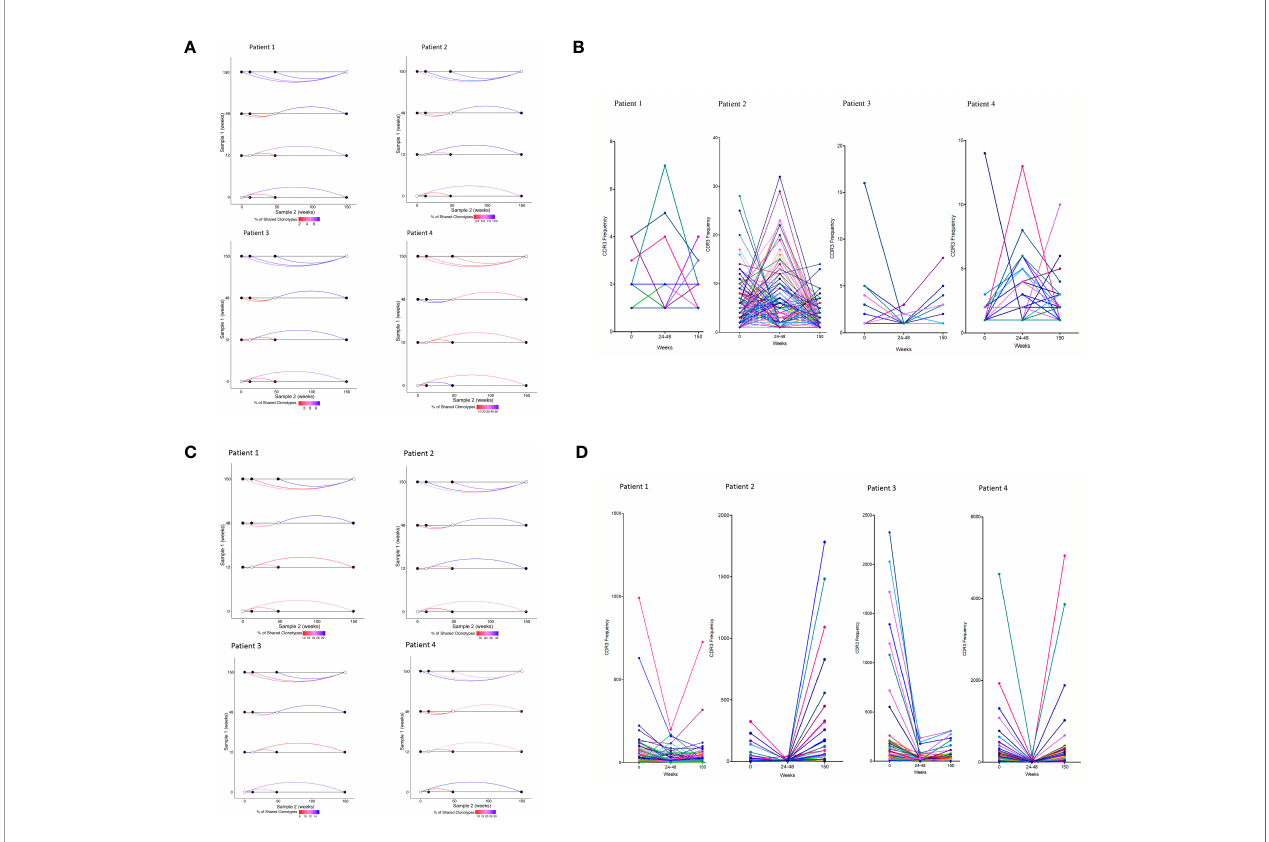
FIGURE 3 | Repertoire dynamics and sequence sharing associated with ART interruption. (A) Shared CDR3s between two time points in individual patients following PTI in naïve CD4 + TCRs and (C) memory CD8 + CDR3s. Shown is the proportion (%) of shared TCR a CDR3s by the color of the connecting line between two time points. The lines are colored red for low sharing and blue for higher sharing. (B) The CDR3 frequency dynamics in individual patients of shared CDR3s in the naïve CD4 + TCR repertories following PTI. (D) The CDR3 frequency dynamics in individual patients of shared CDR3s in the memory CD8 + TCR repertories following